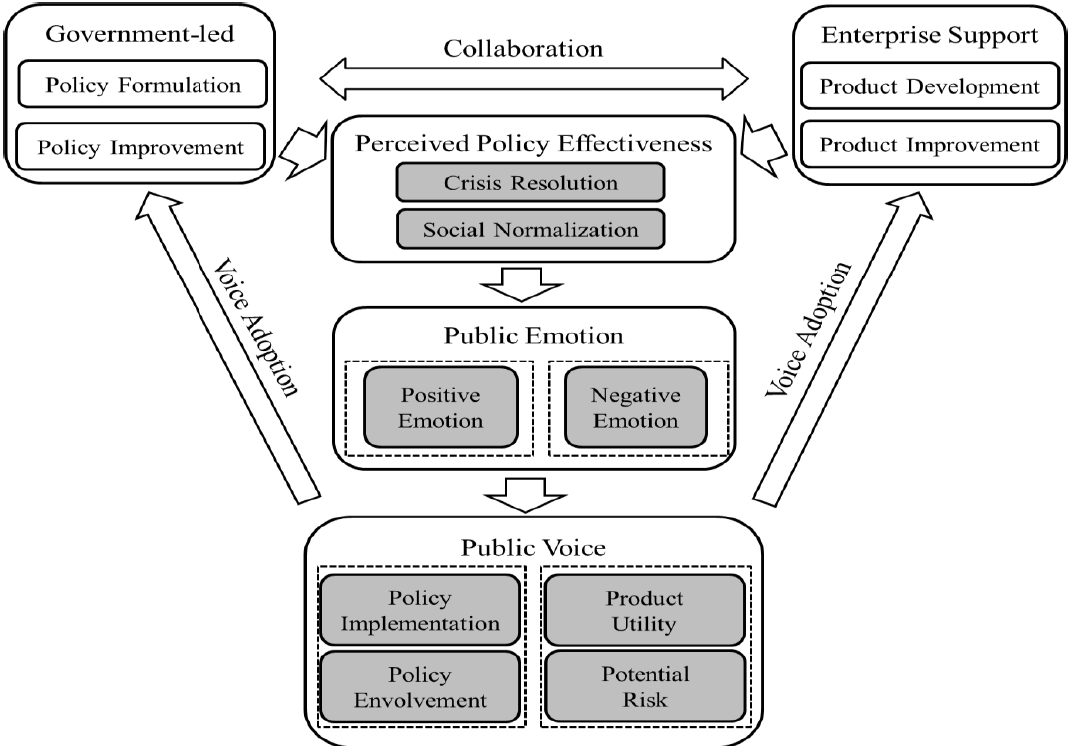
Figure 1. The model of public voice’s formulation and effects. Main categories are shaded grey.